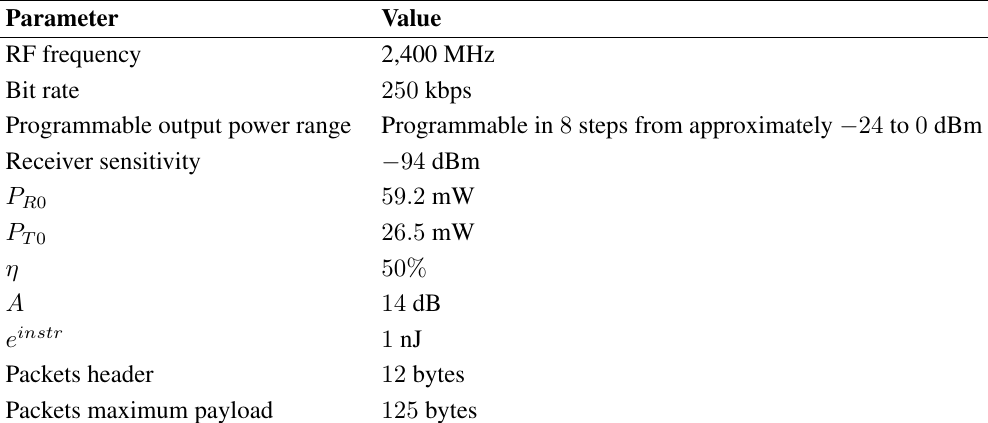
Table 3. Simulation setup